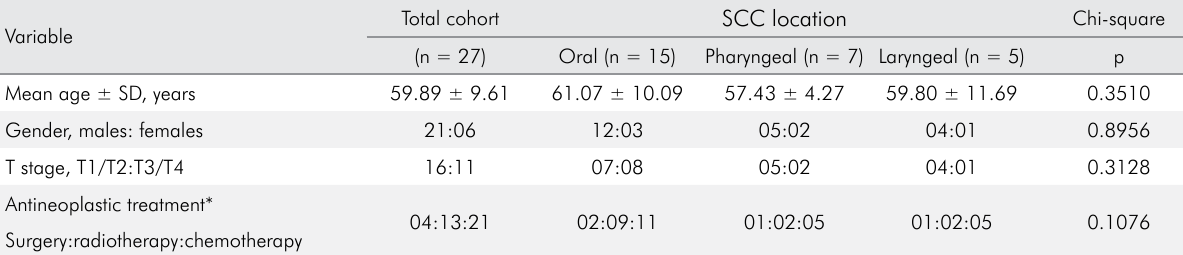
Table 4. Sociodemographic and clinical